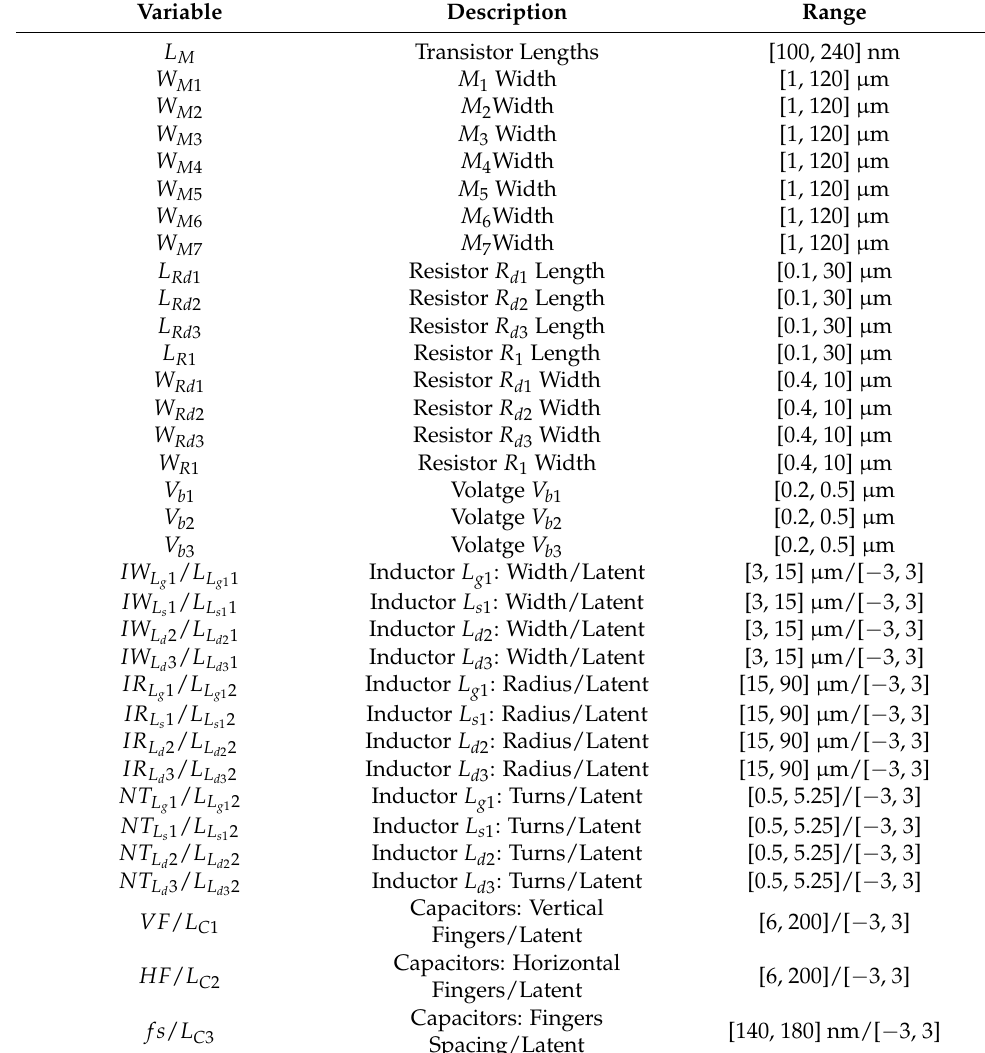
Table 3. Wideband LNA variable ranges.